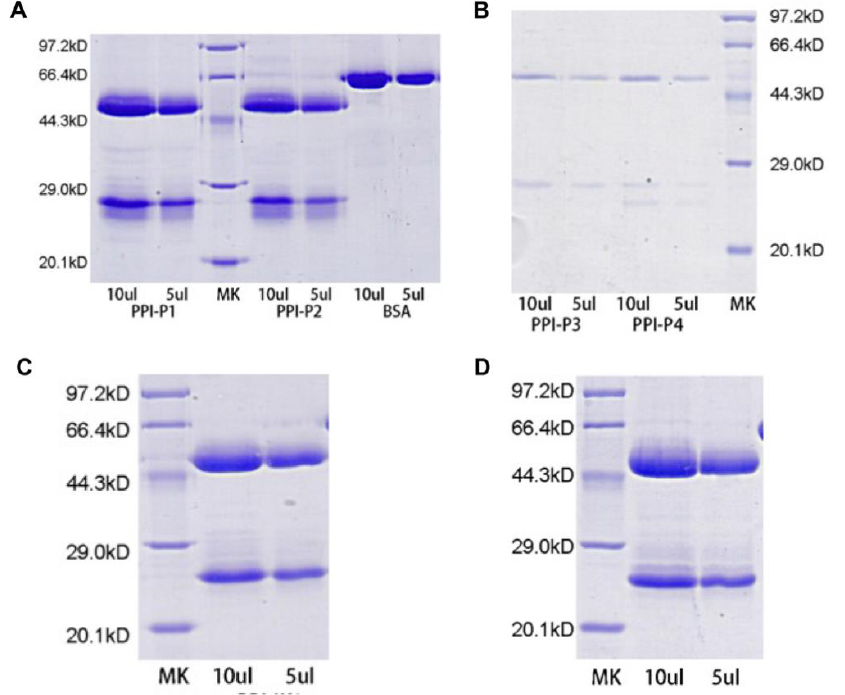
Figure 2. Purification of monoclonal antibodies against PPI. ( A ) Reduced SDS-PAGE showing purification of monoclonal antibodies P1 and P2. 1: 10 μL of P1; 2: 5 μL of P1; 3: 10 μL of P2; 4: 5 μL of